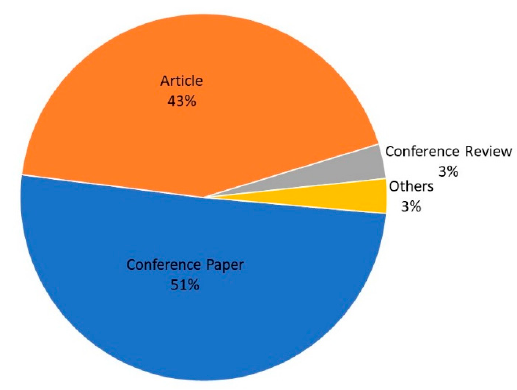
Figure 3. Types of scientific production referred to the electric bicycle (1973–2017).